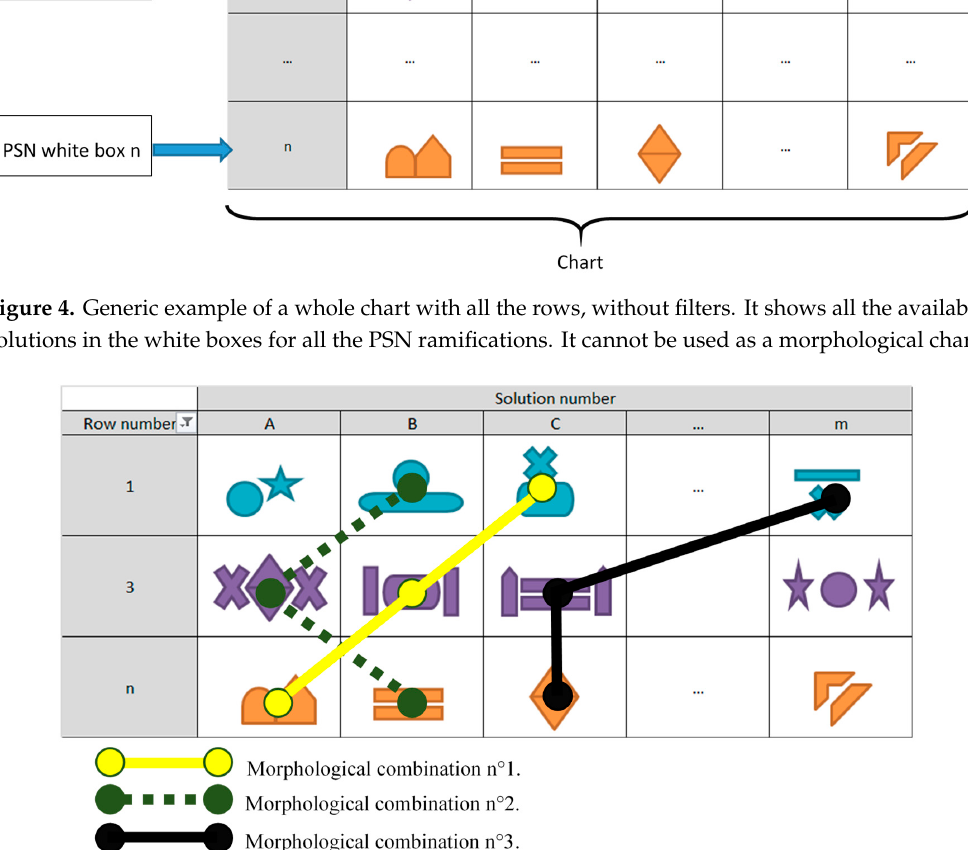
Figure 5. Chart from Figure 4, where filters have been applied (simulating a selection on a hypothetical PSN), and only rows 1, 3 and “n” are active. The filtered chart can now be used as a morphological chart.